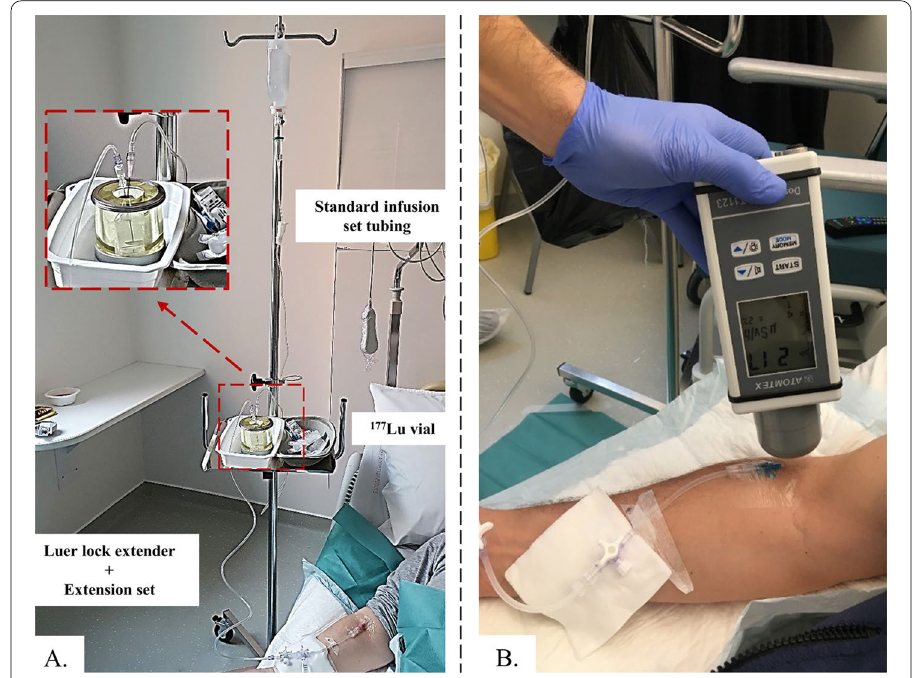
Fig. 1 Illustration of the gravity infusion device ( A ) and equivalent dose rate measurements on the patient’s arm ( B